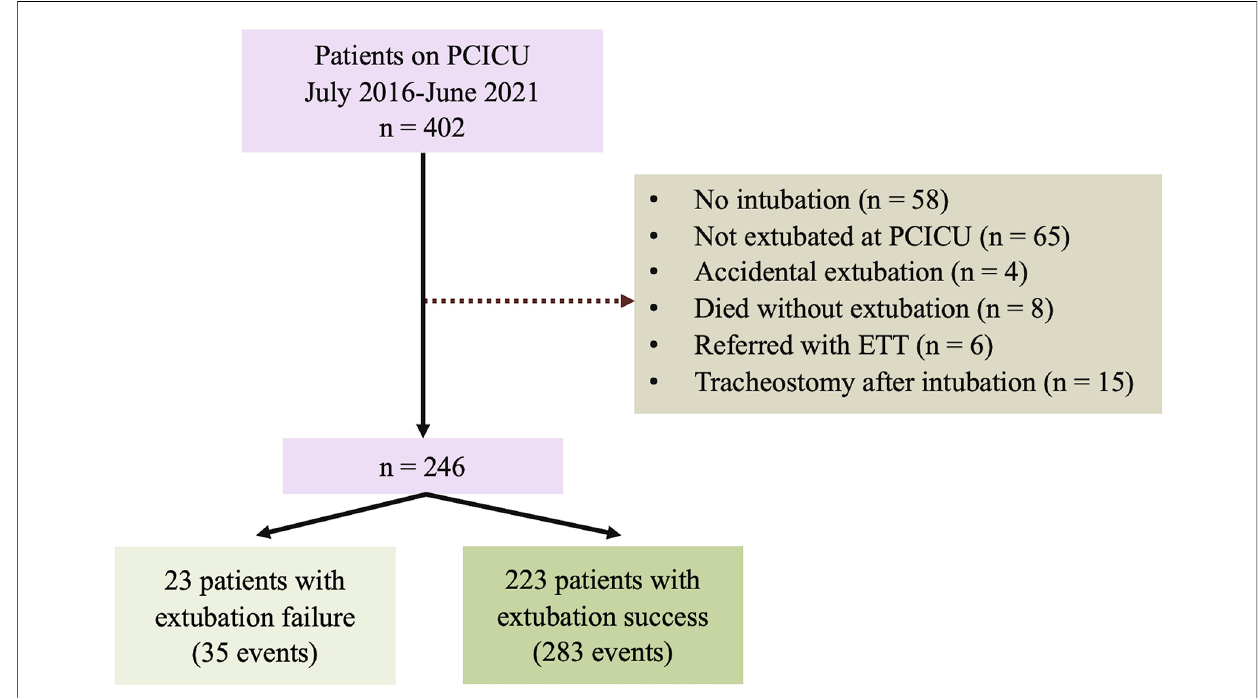
FIGURE 1 Flowchart of the study cohort. ETT; endotracheal tube; PCICU: pediatric cardiac intensive care